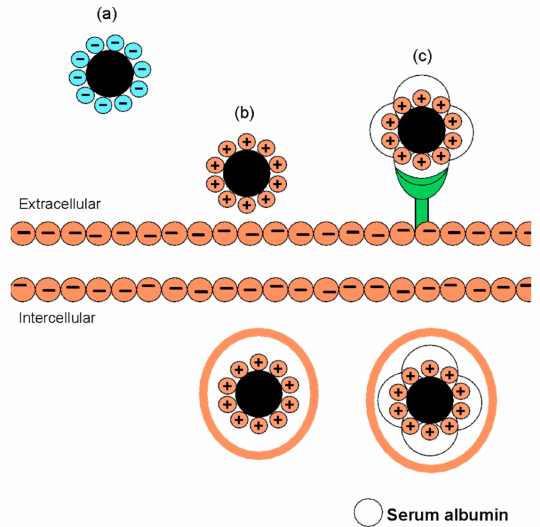
Figure 8. Illustration of the possible uptake mechanisms of FITC-CNC nanospheres with di ff erent surface charges. ( a ) Negatively charged FITC-CNC, which fails to overcome the electrostatic repulsive force against the cell membrane, could not adhere onto the cell surface to initiate membrane wrapping. ( b ) Positively charged or reasonably less negative FITC-CNC could adhere onto the cell surface and is taken up through non-specific adsorptive endocytosis. ( c ) Positively charged or reasonably less negative FITC-CNC could also possibly enter intracellular matrix through receptor-mediated endocytosis by forming